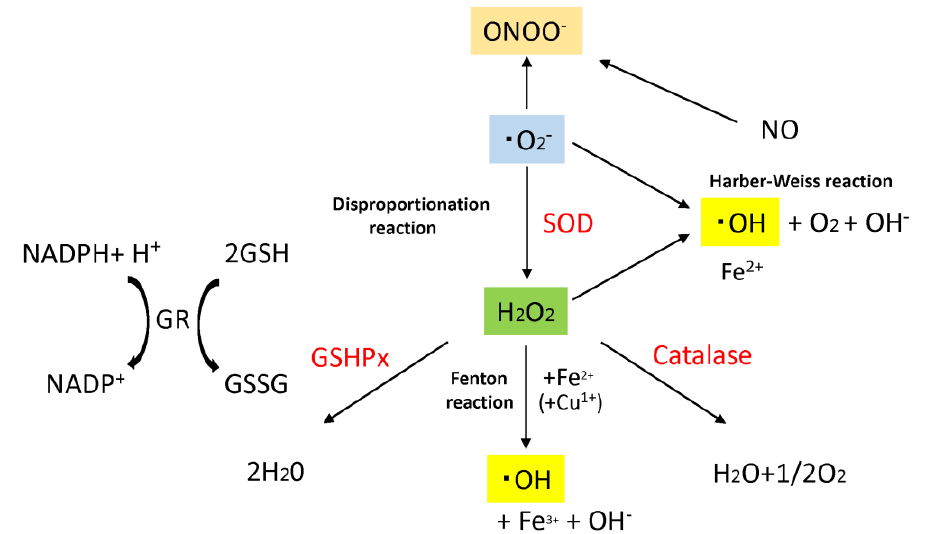
Figure 1. Major generative and eliminative reaction of reactive oxygen species